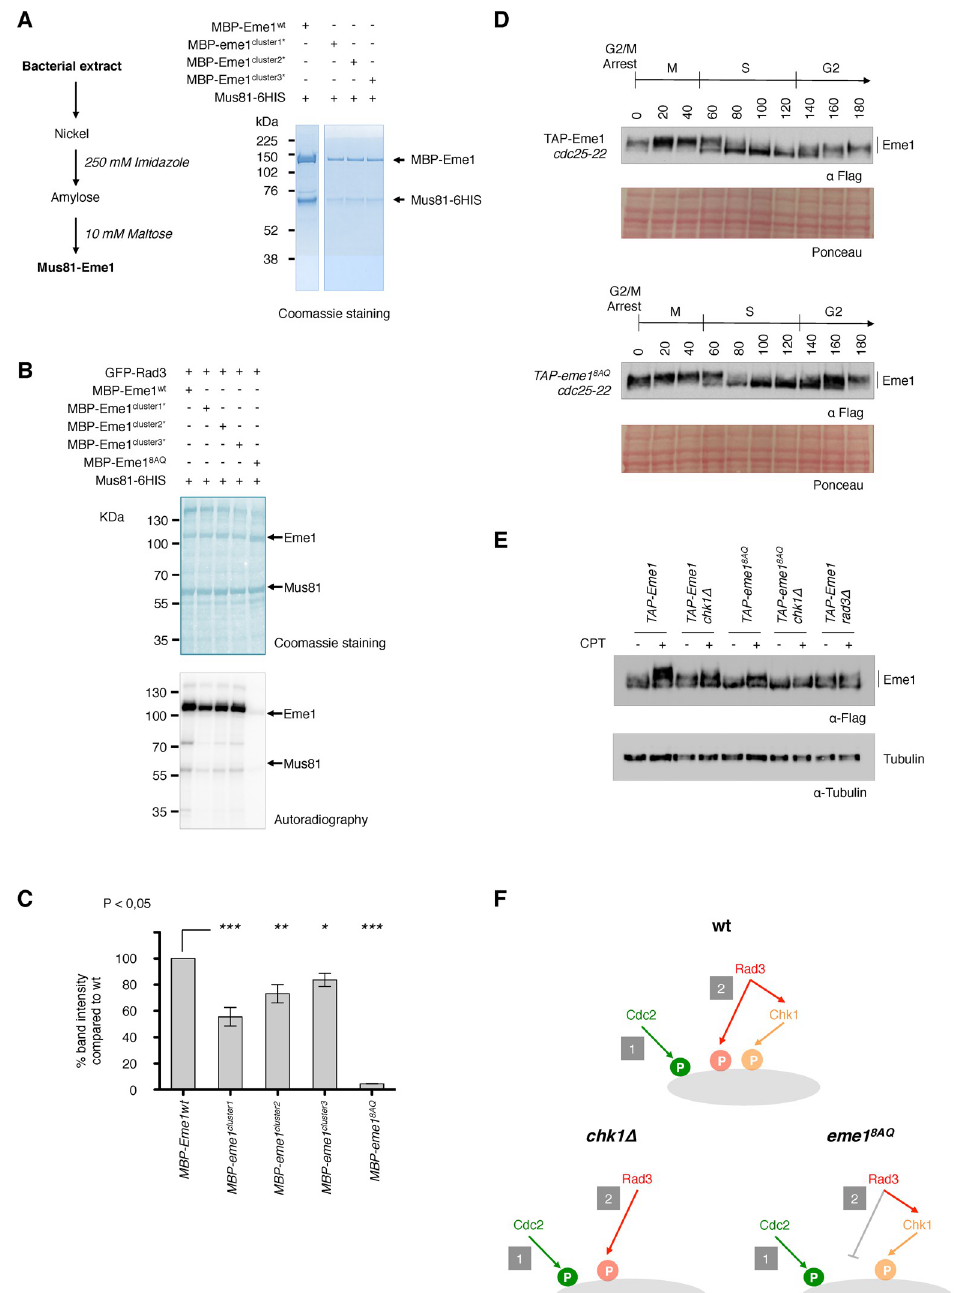
Fig 2. Rad3 ATR directly phosphorylates Eme1 in vitro . A- Recombinant mus81 was co-expressed with either wild- type eme1 , eme1 cluster1 � , eme1 cluster2 � or eme1 cluster3 � and purified from bacterial cultures (purification scheme is depicted on the left). Samples were loaded on an 4–12% Nupage Bis-Tris polyacrylamide gel alongside a Rainbow (Amersham) protein size marker. B- Representative autoradiography of 32 P labeled Eme1. Rad3 ATR in vitro kinase assays were carried out on full-length recombinant Mu81-Eme1 complexes containing either wild-type Eme1 or Eme1 mutated for S 23 /T 50 (cluster1 � ) or S 126 /T 145 /T 215 (cluster2 � ) or S 313 /T 384 /S 458 (cluster3 � ) or S 23 /T 50 /S 126 /T 145 /T 215 /S 313 / T 384 /S 458 (eme1 8AQ ). Samples were loaded on a 3–8% Nupage Tris-Acetate polyacrylamide gel alongside a PageRuler (ThermoFisher) protein size marker. C- Relative band intensity of phosphorylated Eme1 (n = 3). All clusters contribute to Eme1 Rad3 ATR -dependent phosphorylation with S 23 /T 50 (cluster1 � ) being the most important. D- Cultures from cdc25-22 TAP-eme1 and cdc25-22 TAP-eme1 8AQ were synchronized at the G2/M transition and released for one cell cycle. Total proteins were extracted at each indicated time point of the time course and analyzed